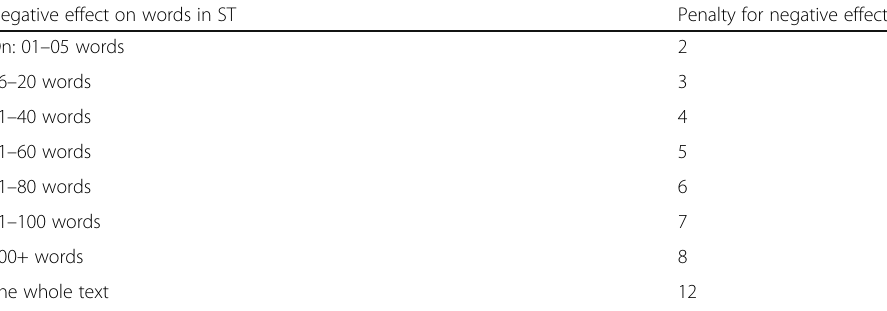
Table 1 Marking system and typology of errors in method B (Waddington